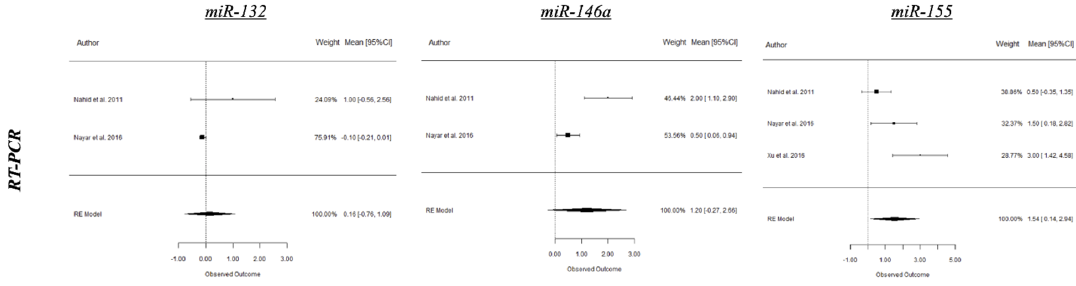
Figure 4. RT-PCR expression of selected miRNAs in periodontal health and experimental periodontitis.